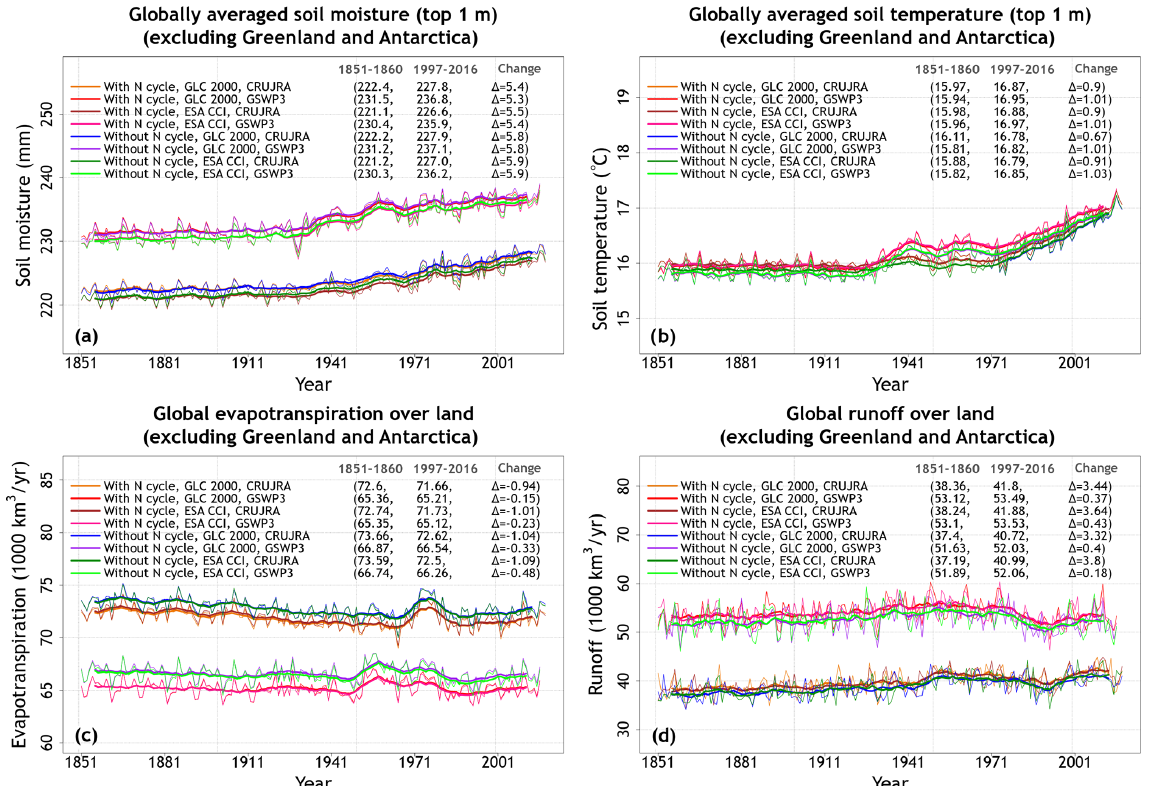
Figure A3. Time series of simulated globally averaged annual soil moisture (a) and soil temperature (b) in the top 1m, global annual evapotranspiration (c) , and runoff (d) from the eight simulations summarized in Table 1. The thin lines show the individual years, and the thick lines show their 11-year moving average. Model values averaged over the pre-industrial (1851–1860) and present-day (1997–2016) time periods, and their difference, are also